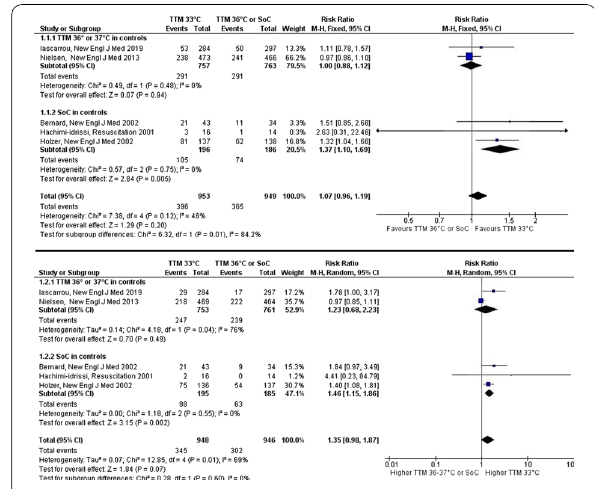
Fig. 1. Forest plot analysis on mortality and neurological outcome in survivors after CA treated with a TTM at 32–34 °C, compared to TTM 36–37 °C or standard of care. Analysis performed with random effect model and Mantel–Haenszel (M-H) Conclusion. Our meta-analysis showed that in adult survivors after CA, TTM at 32–34 °C does not improve survival or neurological out- come compared to control group. However, when looking for sub- groups, TTM at 32–34 °C is associated to a lower mortality and a better neurological outcome compared to standard of care. More studies are needed to evaluate the effect of TTM at 32–34 °C on survival and neu- rological outcome compared to a higher target